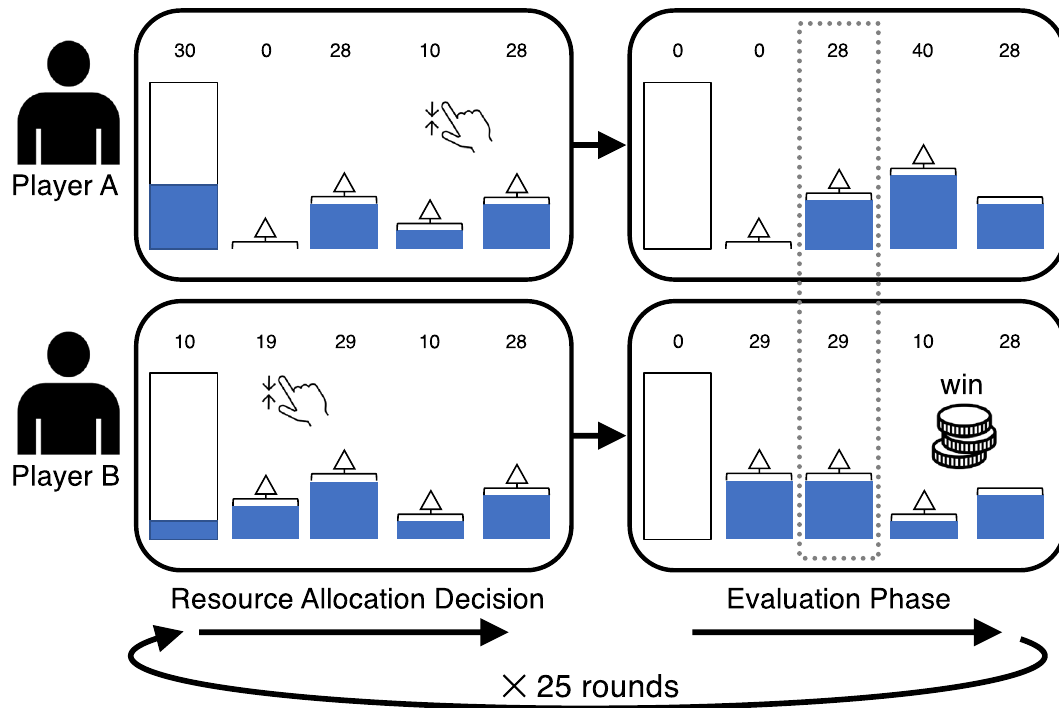
Figure 1. Schematic illustration of a sample trial from the allocation game (Colonel Blotto game). Verbatim instructions and details of procedures are provided in the Supplemental Materials. Participants allocated all of their resources (units) available in each round (depicted in a jar on the left side of the computer screen) across four fields (bins) as they saw fit, by moving corresponding sliders. After their allocation decision, participants clicked on a “next” button. In the evaluation phase, one of the four fields was then randomly selected by the program for comparison between two opponents. A player’s success was defined by a simple deterministic auction function. In the example, Player B wins the round (worth €0.2) against Player A, because Player B allocated more resources to that field than Player A did (29 vs. 28